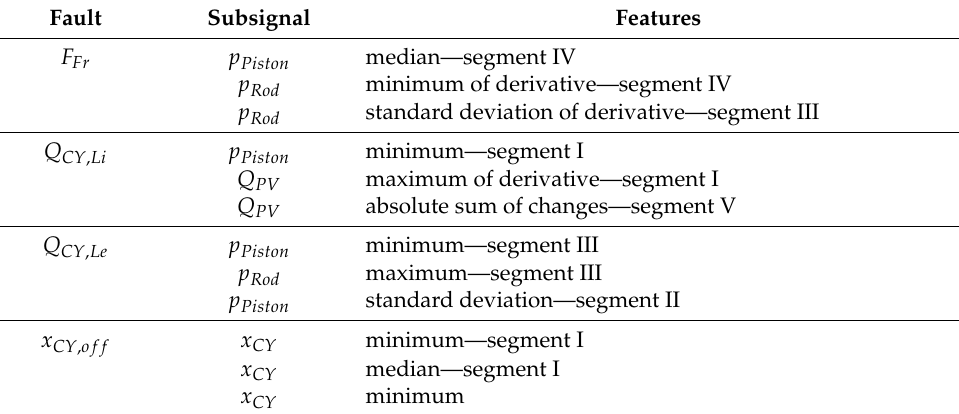
Table 6. Three most important features identified through feature selection for each